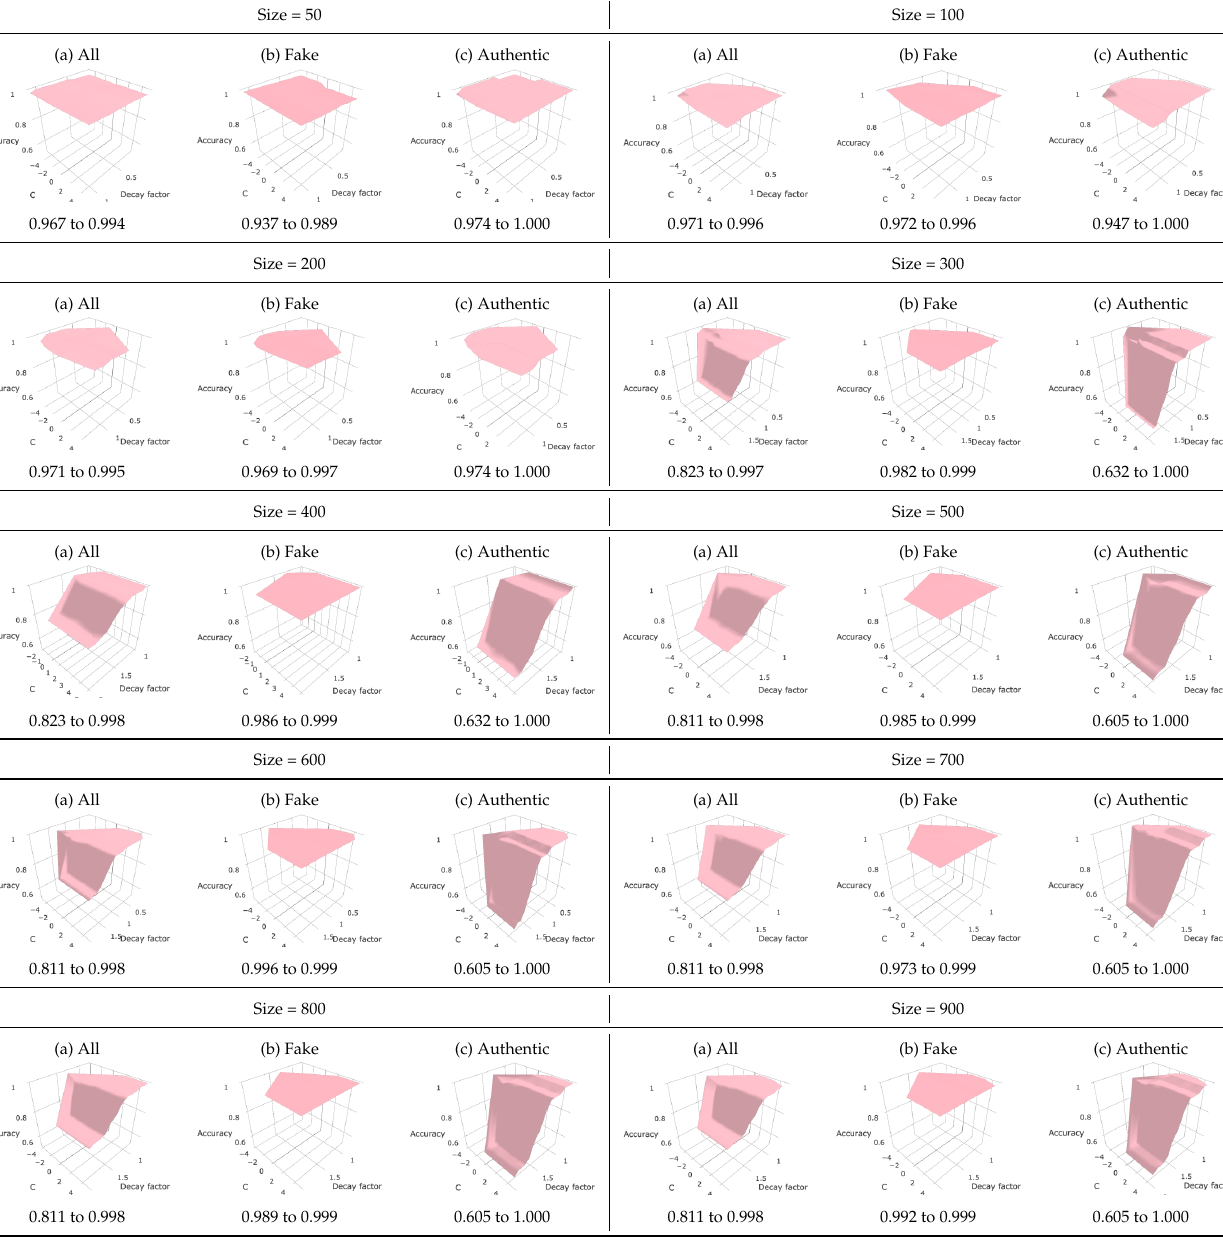
Figure 19. Accuracy scores for 5946 validation examples with models that have learnt n training examples: n = 50, 100, 200, 300, 400, 500, 600, 700, 800,